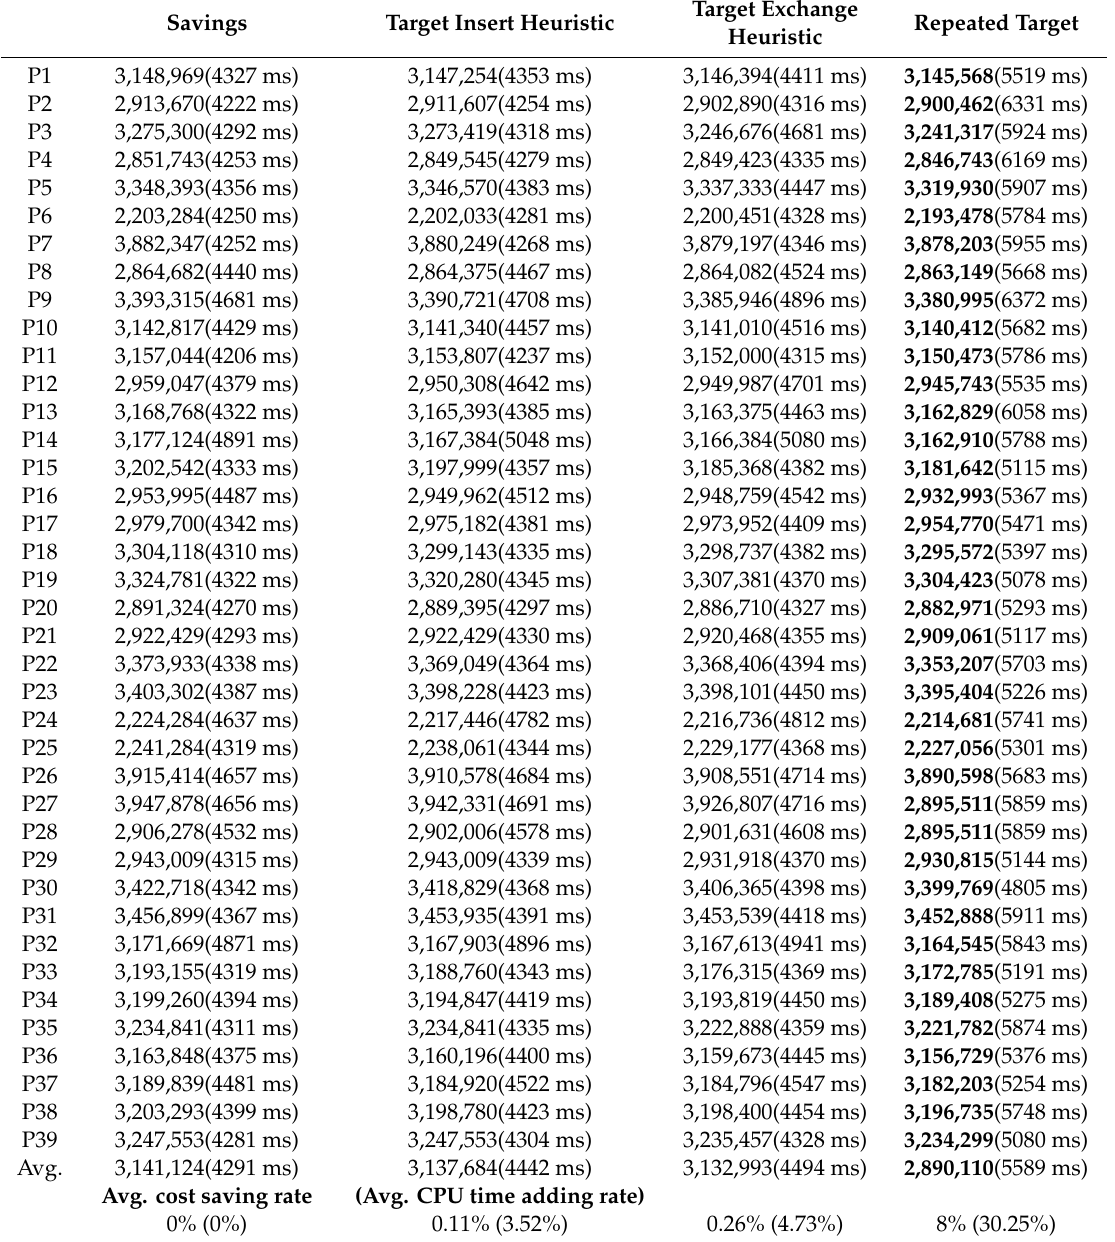
Table 21. The performance of the inventory routing cost and CPU running time for a savings method, a target insert heuristic method, a target exchange heuristic method, and a repeated target heuristic method concerning ROPIRPSDRCO 2 3